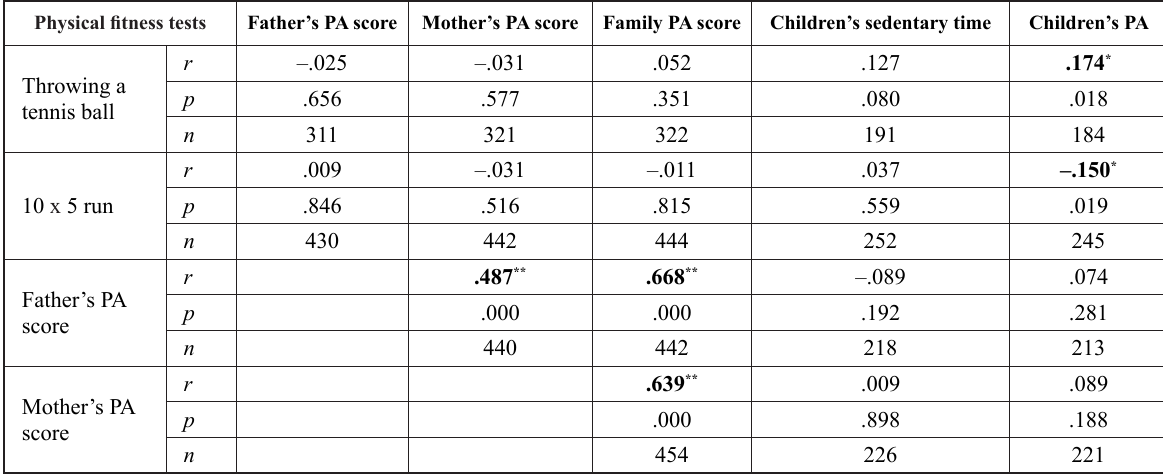
Table 4. Relationship between parents’ and children’ s physical activity and children’ s physical fitness testing